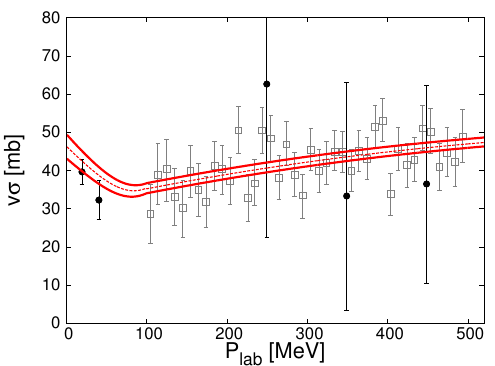
Figure 6 . A (cid:12)t to the data in (cid:12)gure 14 of ref. [19]. The red dashed curve is the best (cid:12)t with (cid:31) 2 = dof = 0 : 74, and the red solid curves show the 1 (cid:27) allowed range. The annihilation cross section at zero momentum from our (cid:12)t is consistent with that of ref. [19]: v(cid:27) = 44 (cid:6) 3 : 5 mb. Open